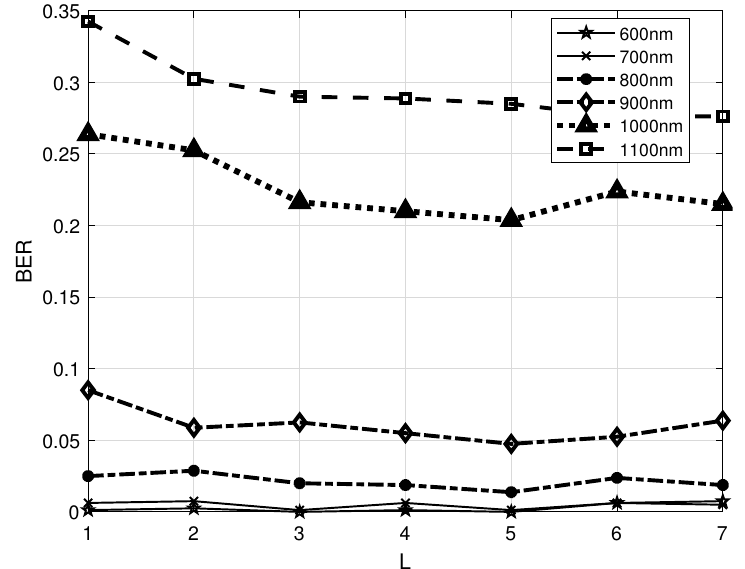
Figure 4. Effect of parameter L on the varying transmission distance of